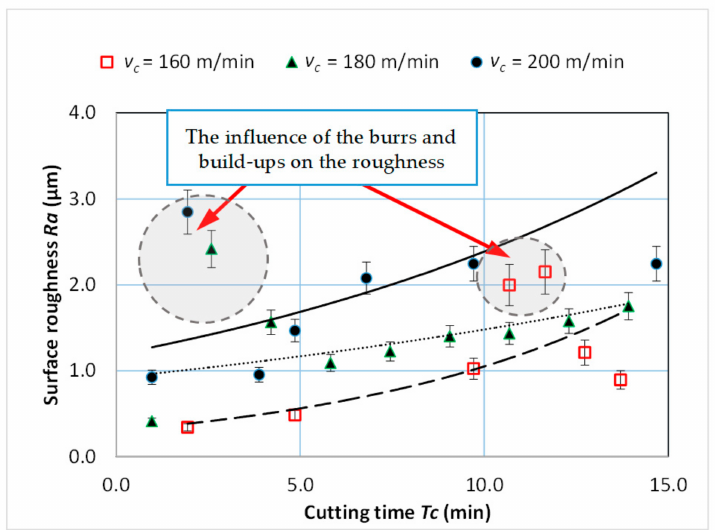
Figure 16. Characteristic of surface roughness Ra as a function of turning time for f = 0.048 mm/rev; a p = 0.5 mm.